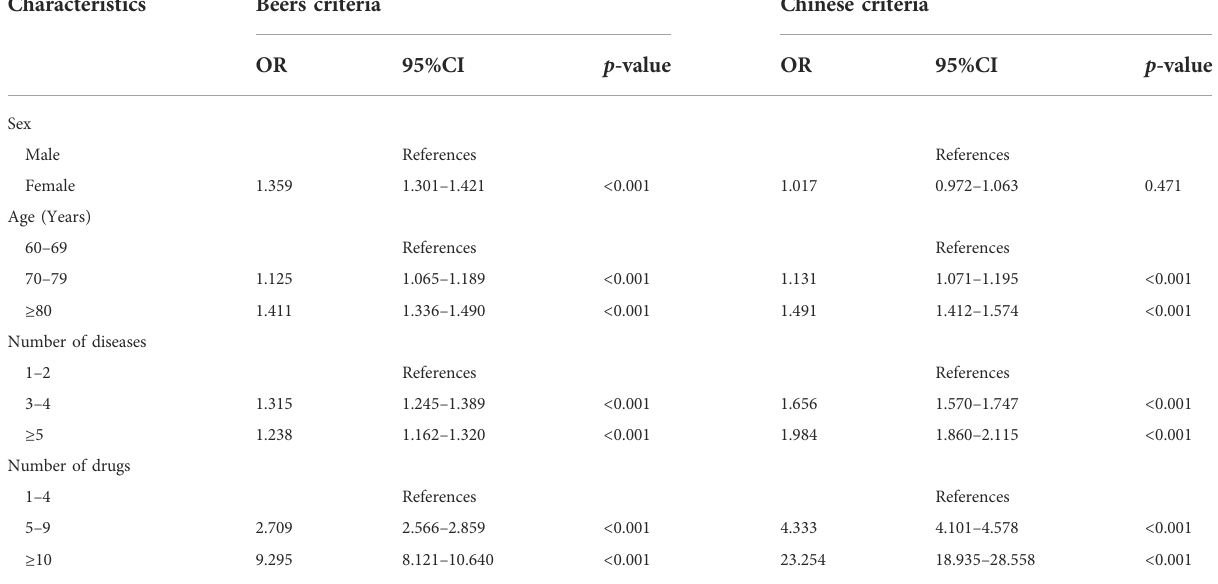
TABLE 4 Binary logistic regression analysis for